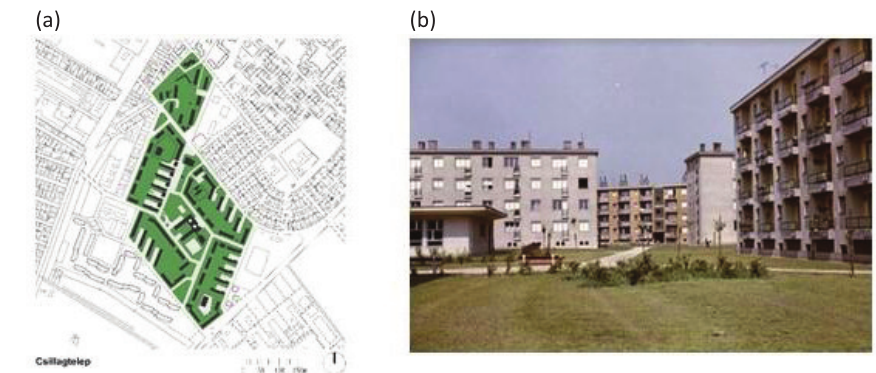
Figure 3. Csillagtelep: (a) Layout and (b) open inner courtyard built in the 1950s. Source: VÁTI (1968).